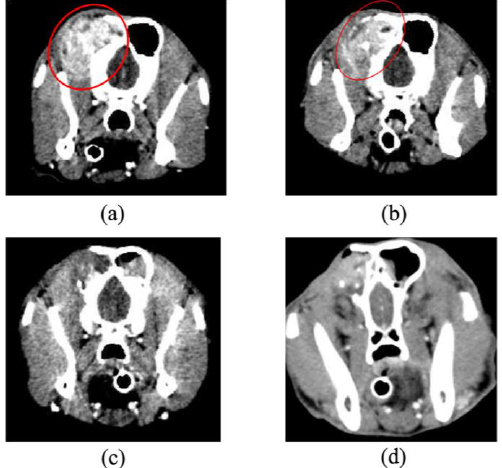
Figure 4. Angiographic computed tomography images of case No. 10. ( a ) The dog was diagnosed with adenocarcinoma of the left paranasal sinus on Day 1. Opacities consistent with soft tissue could be observed in the images of the left nasal cavity and frontal sinus, and the forehead bone was significantly absorbed (red circle). ( b ) The tumor slightly decreased in size on Day 14 (red circle). ( c ) Complete remission was achieved on Day 56. ( d ) Imaging and histological evaluation showed no progression of disease during treatment on Day 304. The dog survived for 718 days after initial presentation.